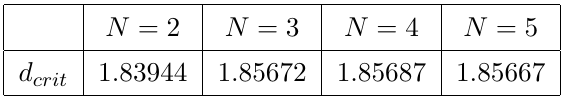
Table 3 . Value of the critical dimension as function of the truncation order N